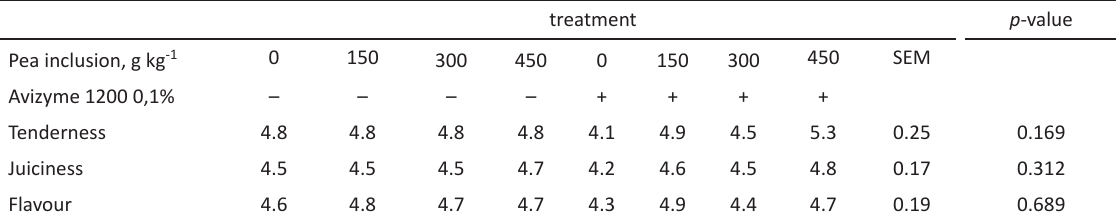
Table 5. The effects of dietary pea inclusion level and enzyme supplementation on the tenderness, juiciness and flavour of breast muscle1. Values are means of 6 observations per treatment (each observation is value of one bird per replicate). treatment p